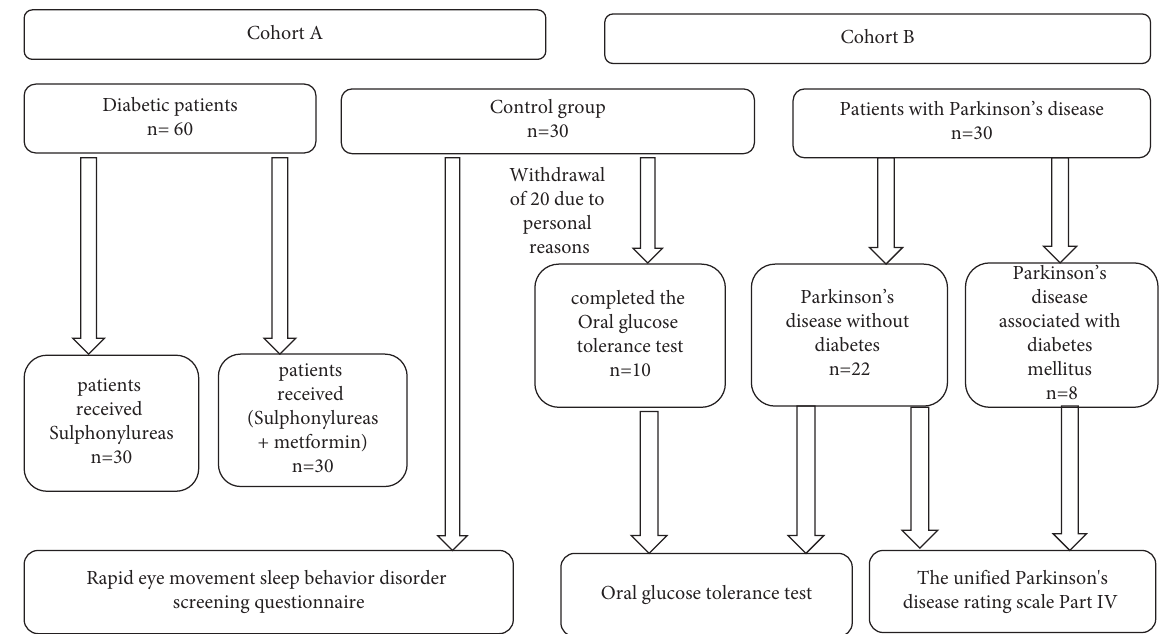
Figure 1: Diagrammatic chart for the study